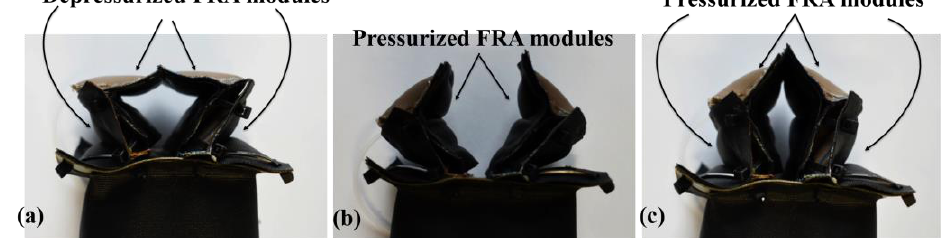
Figure 13. Photo of the end effector in ( a ) initial state, ( b ) intermediate state to prepare for the grasping of objects, ( c ) final state of grasping mode.